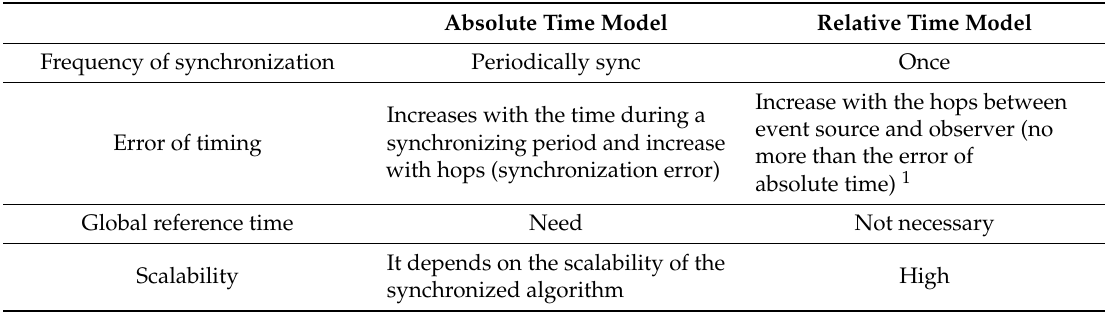
Table 1. Comparison between absolute time model and relative time